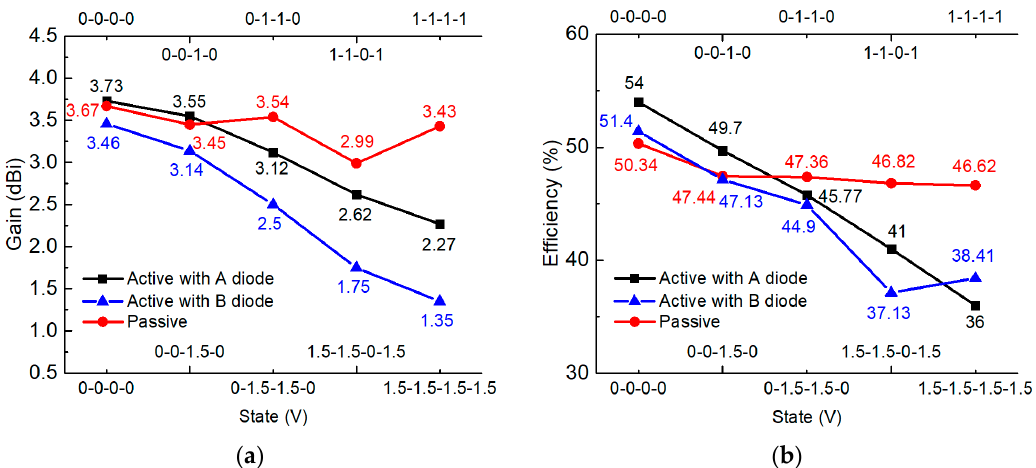
Figure 14. Comparisons between the active antenna and passive antenna with both PIN diodes A and B for ( a ) measured gains and ( b ) the measured efficiency. Table 1. Comparison of different types of